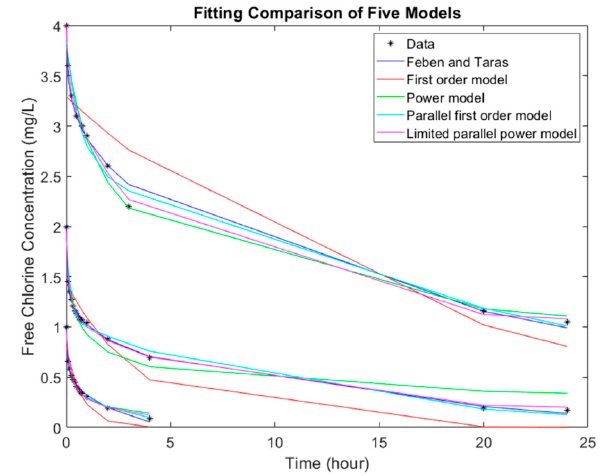
Figure 4. Model regression from the five models on three random tests from experiments.